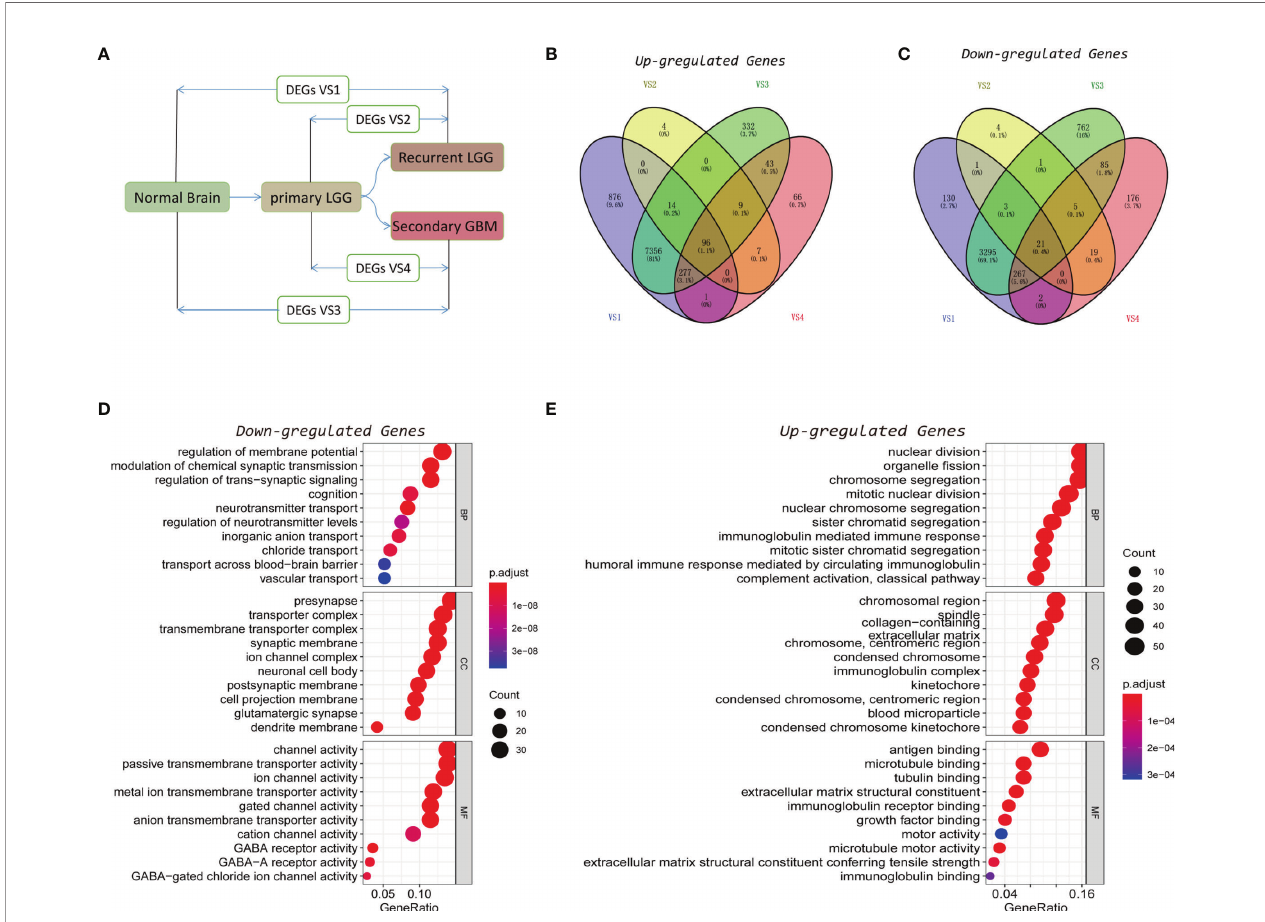
FIGURE 1 | Identi fi cation of recurrence factors in low-grade gliomas. (A) Analysis design diagram of differentially expressed genes (DEGs). (B, C) Venn diagram was used to display the upregulated (B) and downregulated (C) genes in the four sets of DEGs. (D, E) Gene Ontology (GO) analysis of the consistent upregulated (D) and downregulated (E) genes in the four sets of